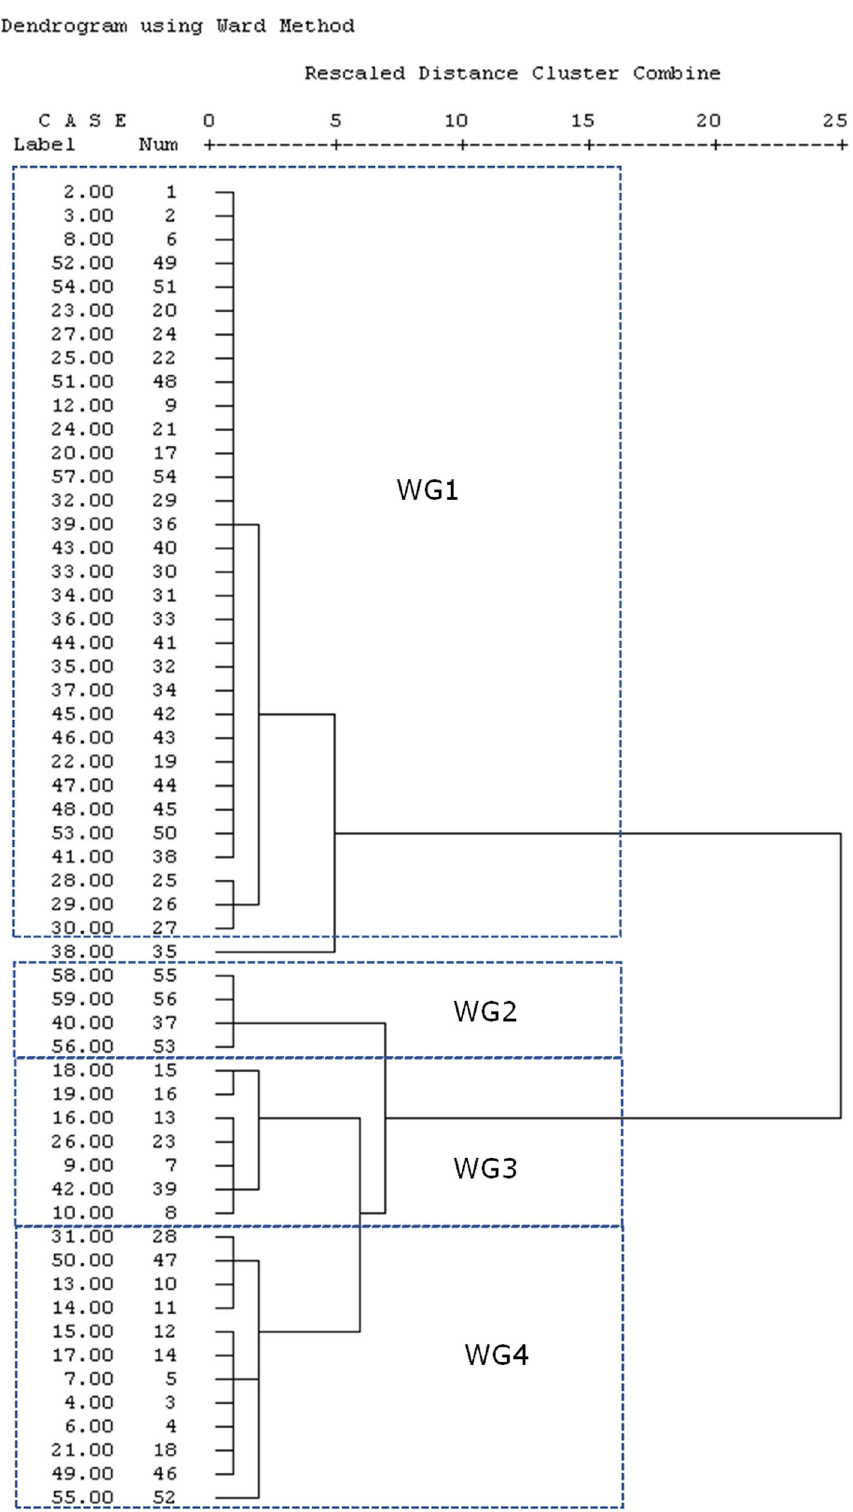
Fig. 6 Dendrogram resulted from Q-mode (wells) HCA